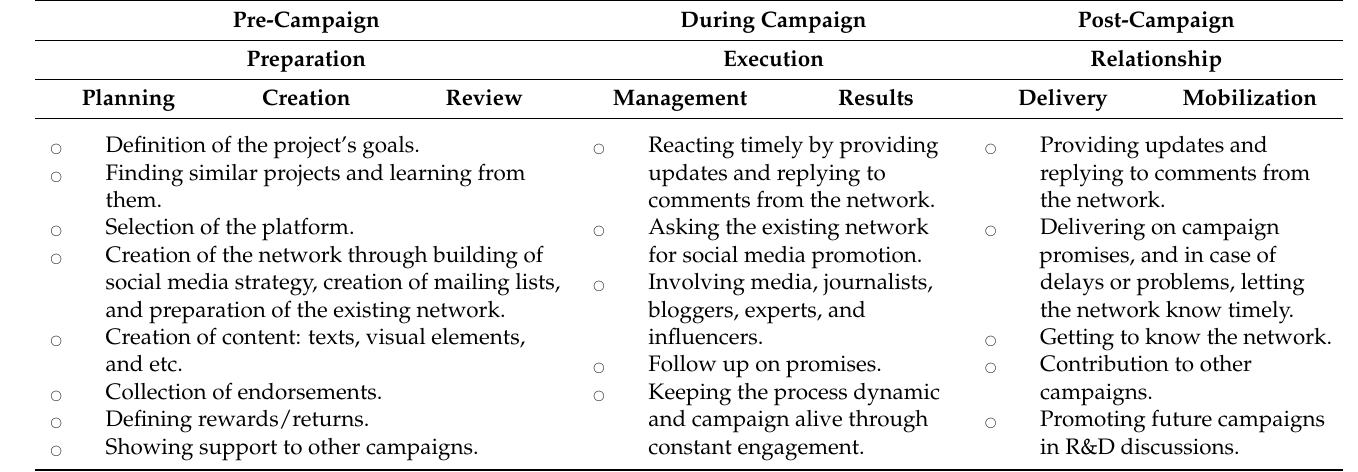
Table 1. The crowdfunding campaign